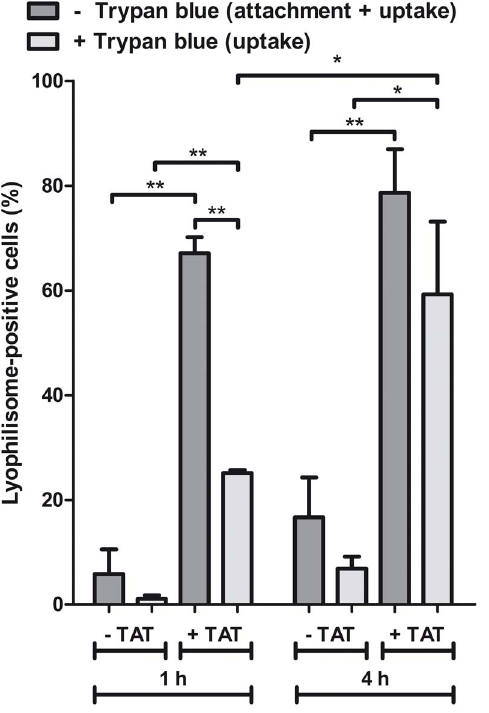
Figure 5. Internalization of lyophilisomes with and without TAT peptide into HeLa cells. FACS showed a large number of lyophilisome-positive cells for TAT-conjugated lyophilisomes after 1 h (67 6 3%) without trypan blue and a cellular uptake of 25 6 1% with trypan blue. Values for lyophilisomes without TAT peptide were low. When lyophilisomes were incubated for 4 h, TAT-conjugated lyophili- somes conserved the large number of lyophilisome-positive cells (79 6 8%) with an increased internalization of 59 6 14%, while unmod- ified lyophilisomes still showed few lyophilisome-positive cells and little cellular uptake. *p , 0.01 **p , 0.001. CPP = cell penetrating peptide; TAT = trans-activating transcriptional activator.